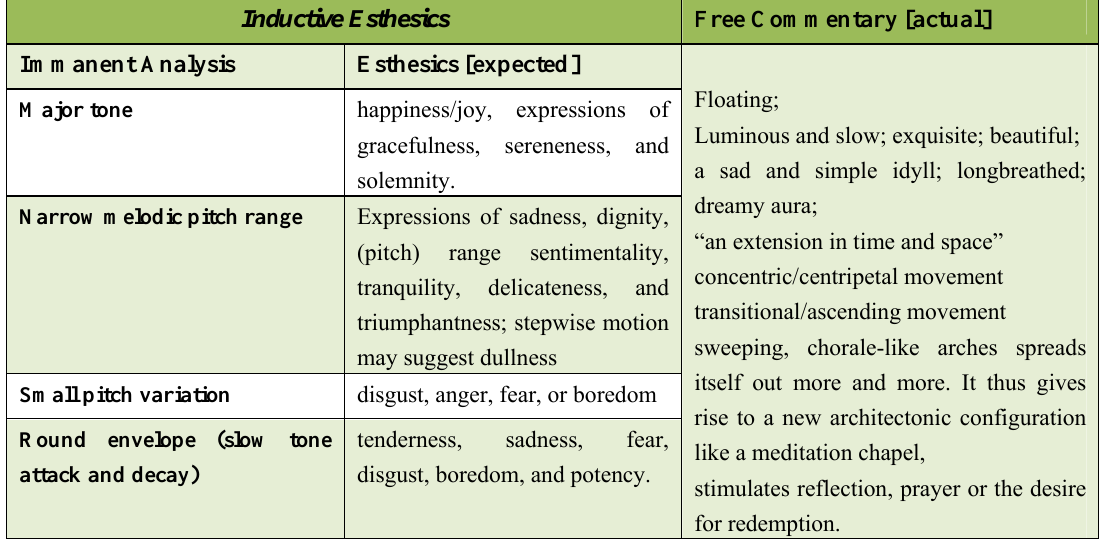
Table 1. Inductive Esthesics and Free